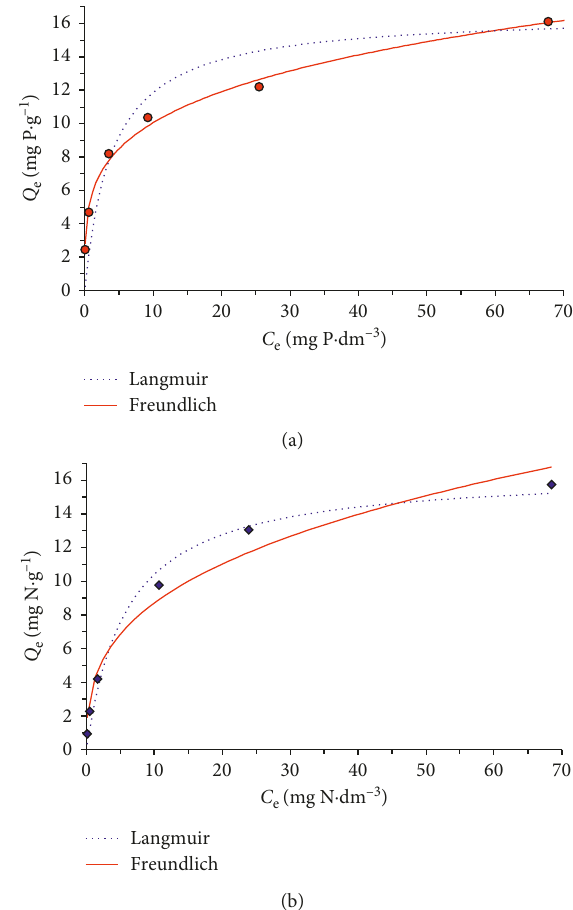
Figure 7: Biosorption isotherms of the nonlinear forms for the phos- phate (a) and nitrate (b) biosorption onto CALV ( C 0 pH 6.5; T 20 ° C; 60min; 150rpm). (cid:30)